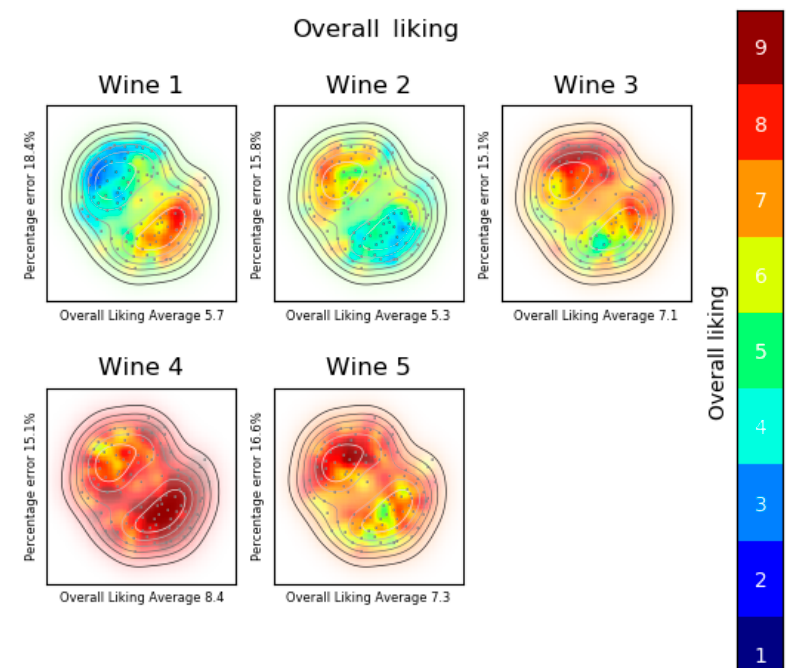
Figure 5. Overall liking analysis. Liking product landscape, consumers’ map created with multidimensional scaling (MDS) fed with overall liking just about right (OLJAR) and product acceptance maps created with support vector machines (SVM). The two groups correspond to women and men. Women consumers are on the top-left side and men consumers on the bottom-right side.